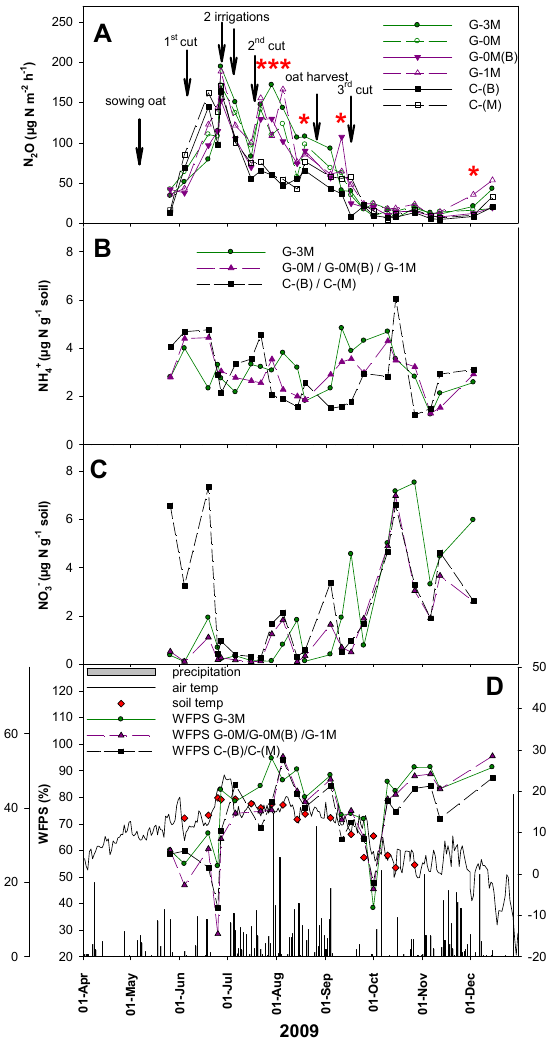
Fig. 1 Fig. 1. (A) Average N 2 O fluxes (µgNm − 2 h − 1 ) during the year of GM management (2009). Standard deviations are omitted to increase readability. Dates with significant treatment differ- ence in N 2 O emissions are marked by asterisk. (B) Soil NH + 4 (µgNg − 1 soil). (C) Soil NO − (µgNg − 1 soil). Mineral N concen- 3 trations are from one composite sample (0–20cm) per treatment on each sampling date. (D) Daily precipitation, air temperature, soil temperature and %WFPS at the time of flux measurement. Soil samples from G-0M, G-0M(B) and G-1M (until 3rd cut) as well as C-(B) and C-(M) were pooled, since these plots were treated equally in 2009. See Table 2 for treatment